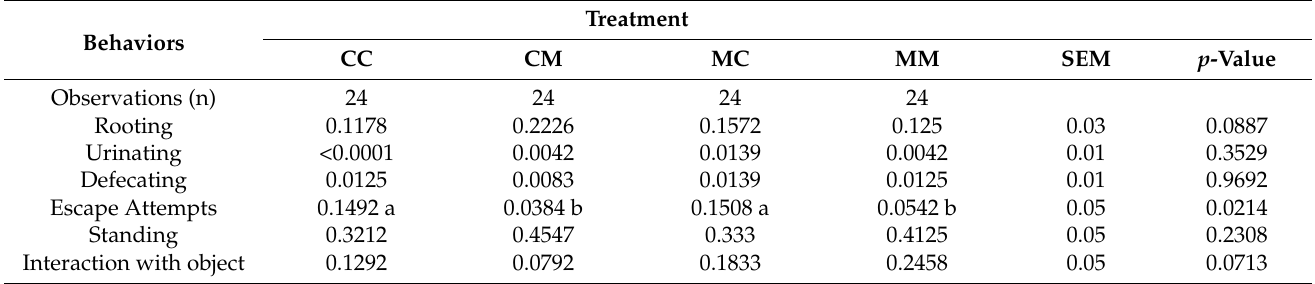
Table 2. Effect of auditory environmental enrichment on the mean proportion behavior of piglets distributed in CC treatments: control-control; CM: control-music; MC: music-control; MM: music- music, during the novel object test.